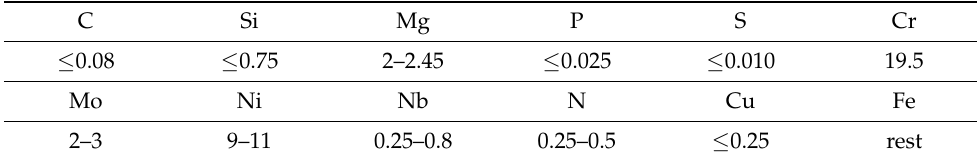
Table 1. Chemical composition of the test material